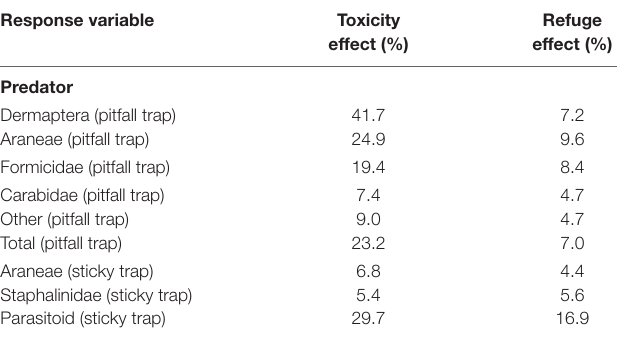
TABLE 3 | Relative strength of effect from pesticide regime used in the field (“toxicity effect”) and from the presence of woody vegetation adjacent to one margin of field (“refuge effect”) on various natural enemy groups derived from Bayesian network sensitivity analysis.